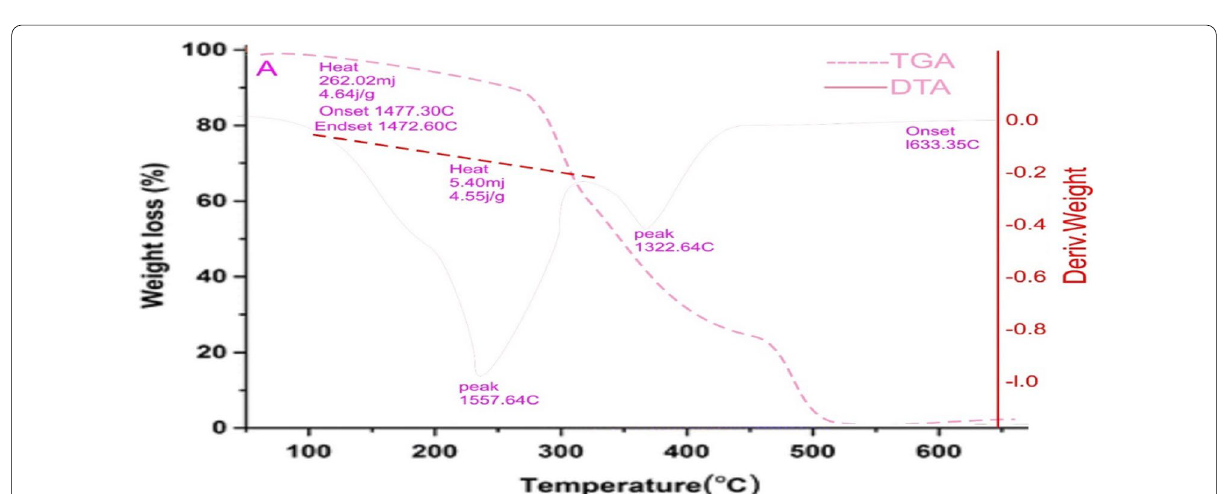
Fig. 5 Effect of temperature on weight degradation of the nanocomposite